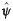
Mean occupancy (ψ^ ±SD, 95% BCI) for the complete study area during 2003–2012, in the regional bird monitoring program in Argentina for mostly Passeriformes species.(a) Granivores; (b) insectivores mostly associated with folliage; (c) other insectivores. For details of species names and guilds, see S1 Table.